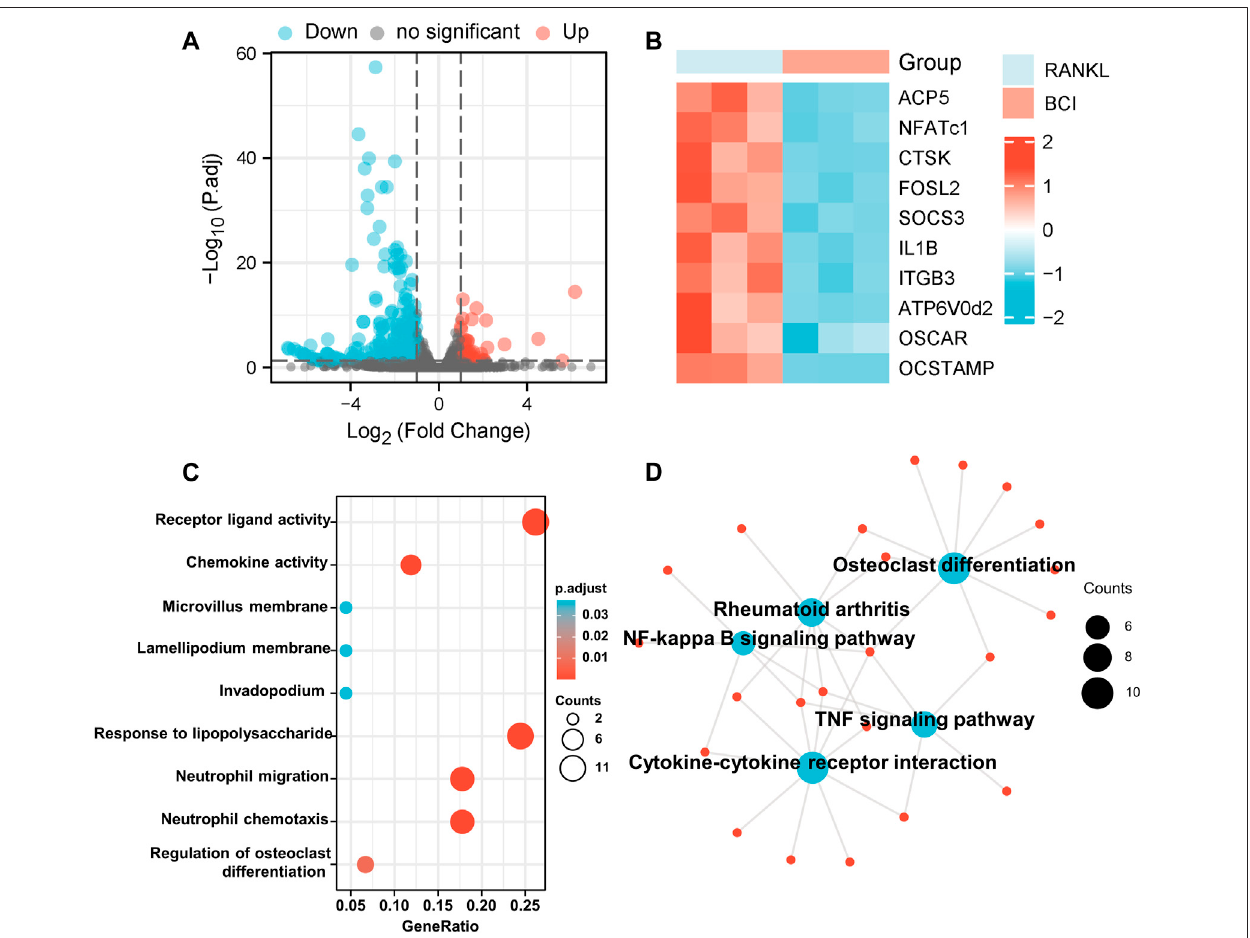
FIGURE 4 | Transcriptome analysis of BCI-treated osteoclast differentiation. (A) The distribution of DEGs is presented as a volcano plot. (B) Heatmap illustrating differencesintheexpressionofosteoclast-speci fi cgenesbetweenRANKL-inducedBCI-treatedand-untreatedgroupsviatranscriptomeanalysis. (C,D) GOandKEGG enrichment results for the top 50 DEGs between RANKL-induced BCI-treated and -untreated groups. * p < 0.05, ** p < 0.01, *** p < 0.001.